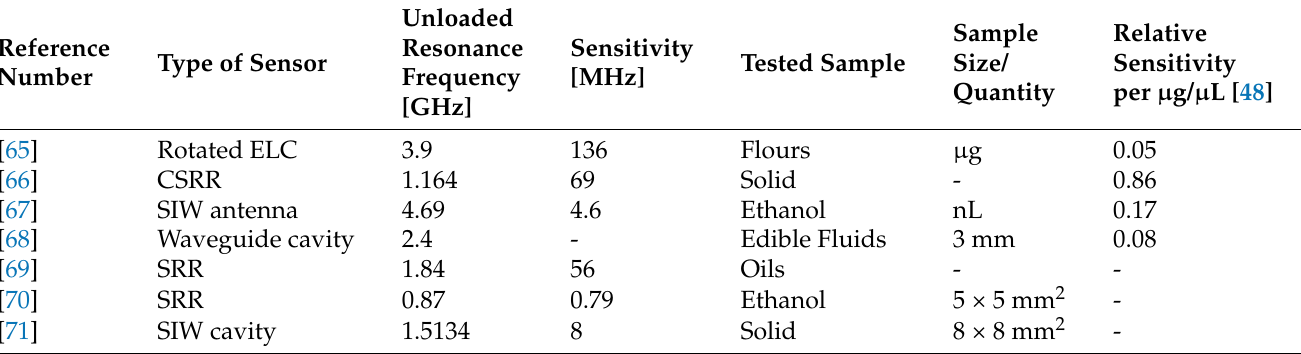
Table 16. Performance comparison based on sensitivity of the sensor described in this work with other high sensitive sensors available in the